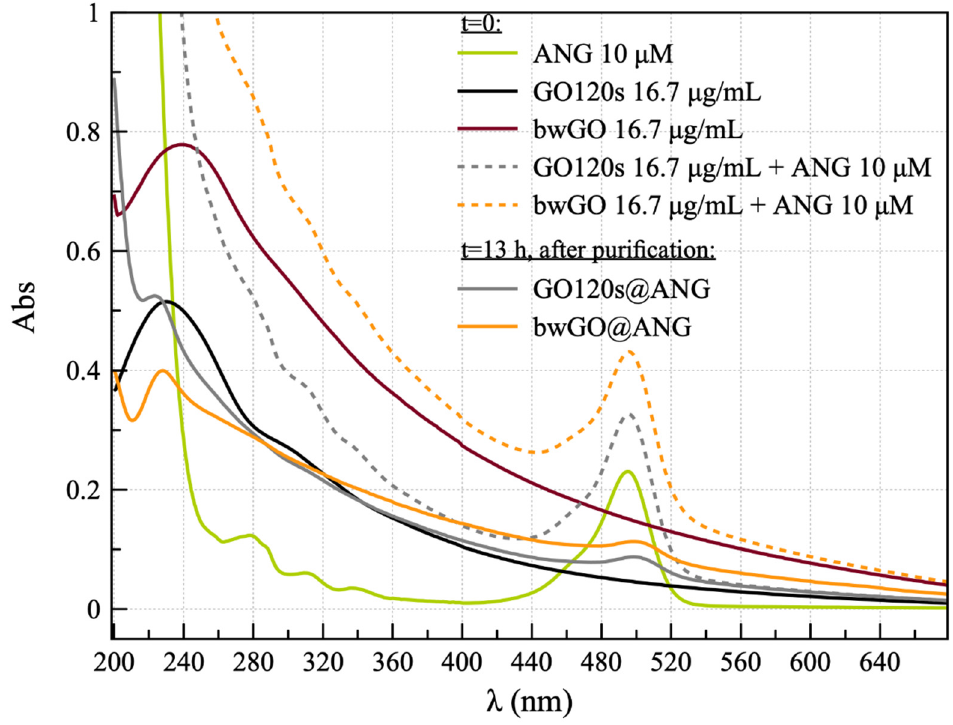
Figure 1. UV-vis spectra for the ANGAF488 protein (green solid line); GO120s (black solid line); bwGO (wine solid line); and the nanohybrids before incubation (t = 0: GO120s + ANG, gray dashed line; bwGO+ANG, orange dashed line); and after overnight incubation and purification (t = 13 h: GO120s@ANG, solid grey line; bwGO@ANG, solid orange line).